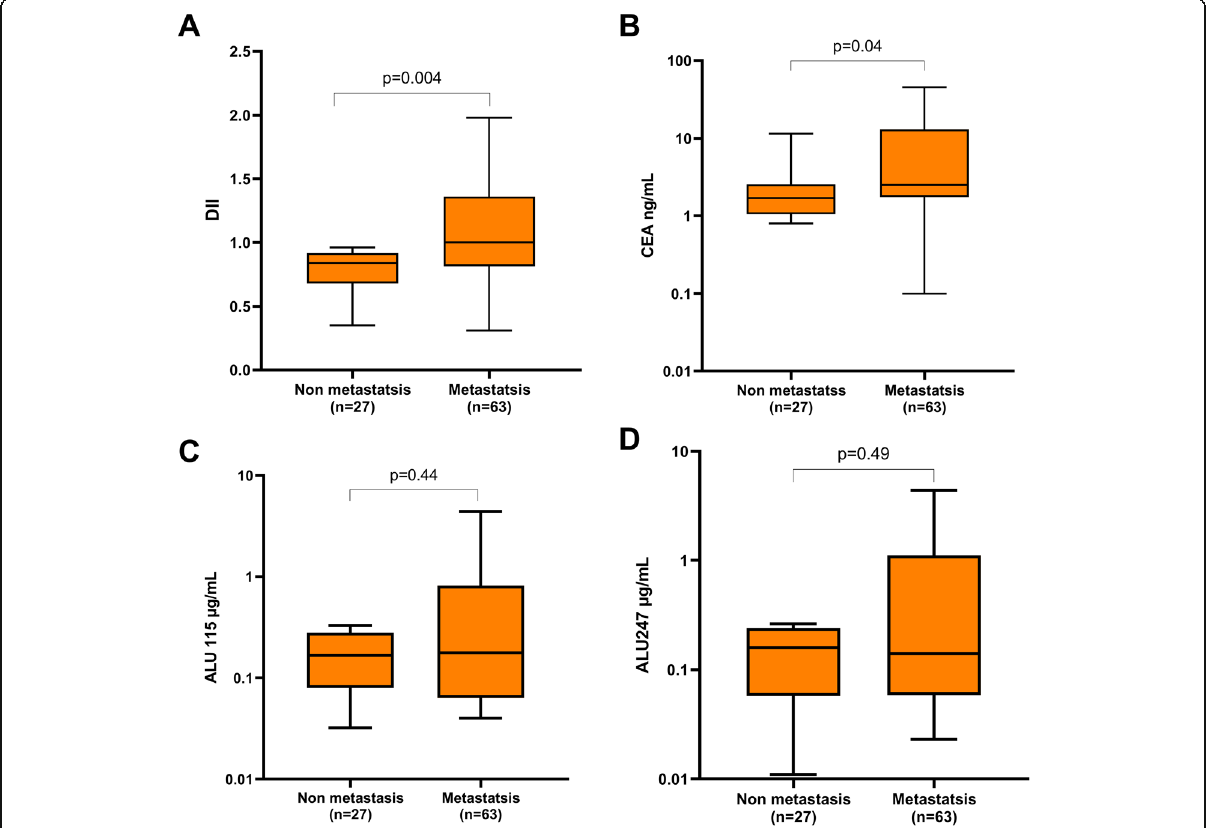
Fig. 3 Higher DII ( a ) and CEA ( b ) in metastatic CRC patients than in the non-metastatic patients while no difference was observed in ALU115 ( c ) and ALU 247 ( d